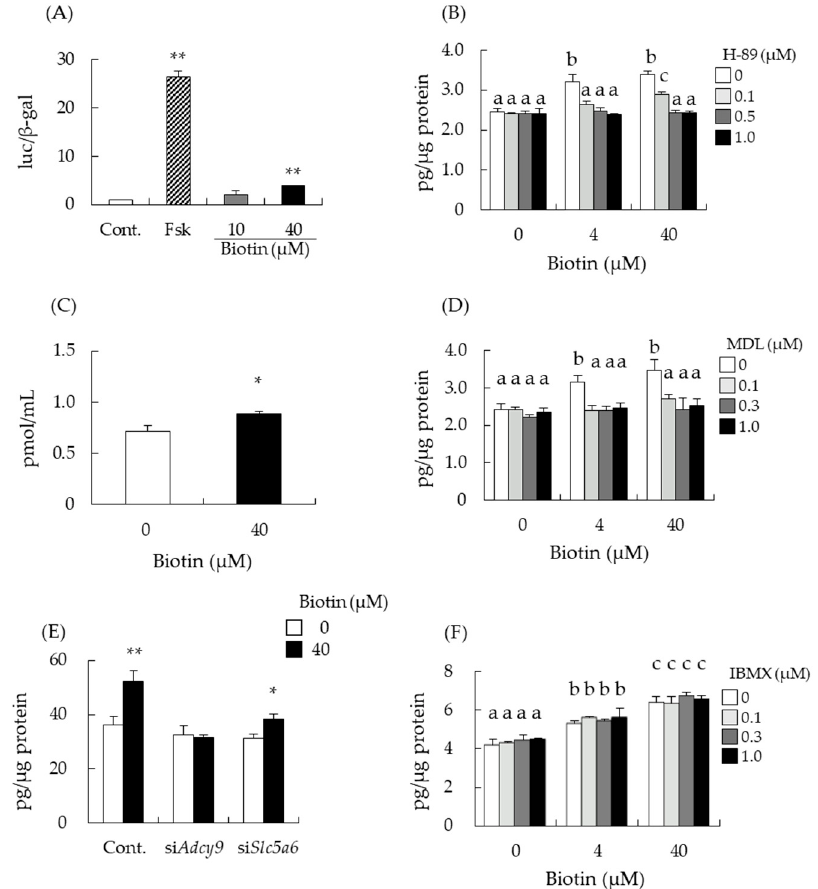
Figure 3. Biotin stimulates testosterone production via the cAMP/PKA pathway. CREB-mediated reporter activities were measured 3 h after the treatment of forskolin (Fsk), an activator of ADCY, or biotin ( A ). The testosterone levels in the I-10 cells cultured medium with/without biotin and PKA inhibitor H-89 for 24 h were measured by ELISA ( B ). cAMP levels in I-10 cell lysate after the treatment of biotin for 1 h were measured by ELISA ( C ). The testosterone levels in the I-10 cell culture medium with/without biotin, ADCY inhibitor MDL ( D ) and PDE inhibitor IBMX ( F ), were measured by ELISA after 24 h of treatment. The testosterone levels of the medium from I-10 cells, transfected with siRNAs targeting Adcy9 or Slc5a6 , were also measured ( E ). Data are presented as mean ± standard error (n = 3). Values with different letters are significantly different at p < 0.05 vs. the 0 µ M biotin group, Tukey–Kramer. * p < 0.05, ** p < 0.01 vs. the control (Cont.) or the 0 µ M biotin group,